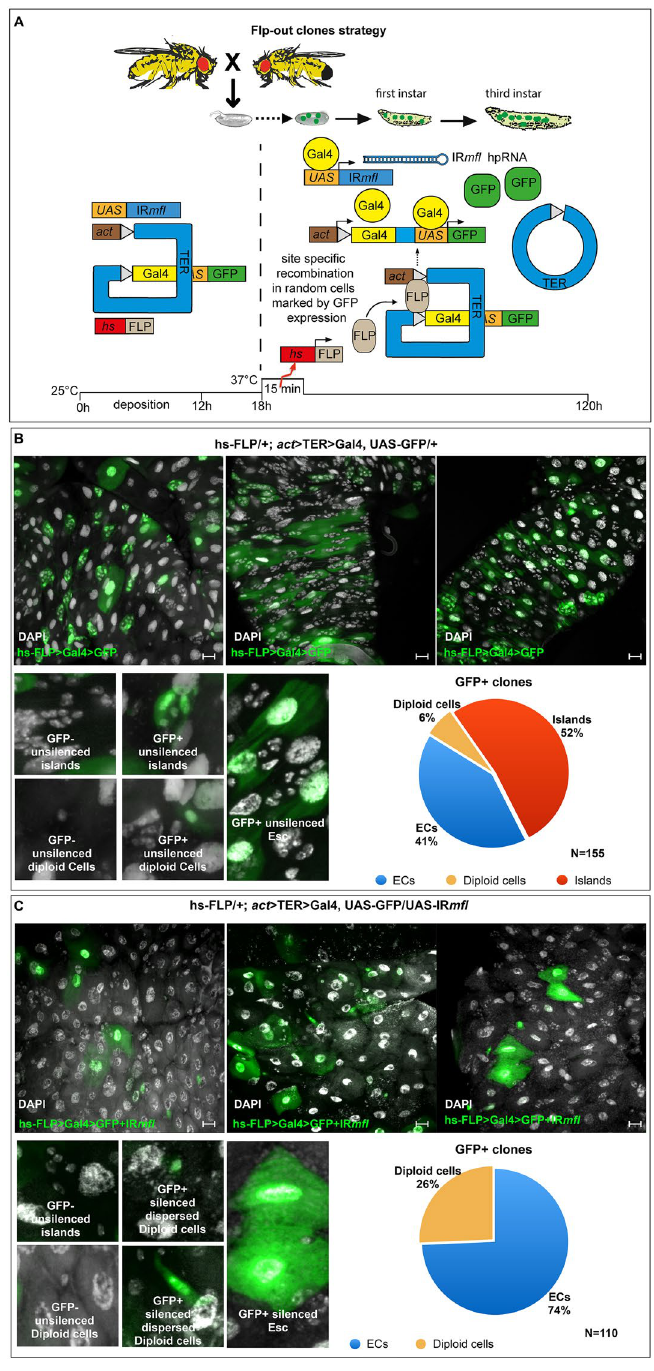
Figure 2. Disruption of the midgut stem cell niches is a cell-autonomous effect. ( A ) Scheme of FLP-OUT clone strategy. Heat-shock-induced expression of Flp fuses actin promoter to the Gal4 coding sequence, by removing an internal cassette containing a transcriptional termination site (Stop) flanked by two FRT sites. In clones expressing Gal4, both the UAS-GFP construct (used as marker) and the UAS-IR mfl silencing construct were activated. At the third larval stage, midguts were collected, stained with DAPI (in grey) and analyzed in epifluorescence. Different regions of the midgut are shown. Scale bars: 20 µ m. ( B ) In control midguts, GFP + unsilenced clones (N = 155) include imaginal islands (52%), ECs (41%) and unsilenced diploid dispersed cells (6%). ( C ) GFP + silenced clones (N = 110) are instead formed uniquely by ECs (74%) or by dispersed diploid cells (26%). These clones never include imaginal islands, although these structures are correctly formed in the surrounding GFP- (unsilenced)